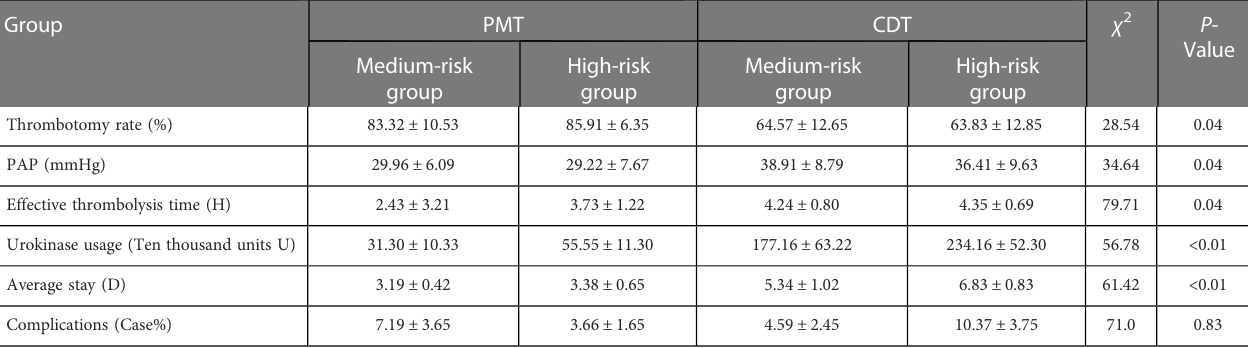
TABLE 3 Comparison of indicators related to surgical ef fi cacy in the two patient groups.